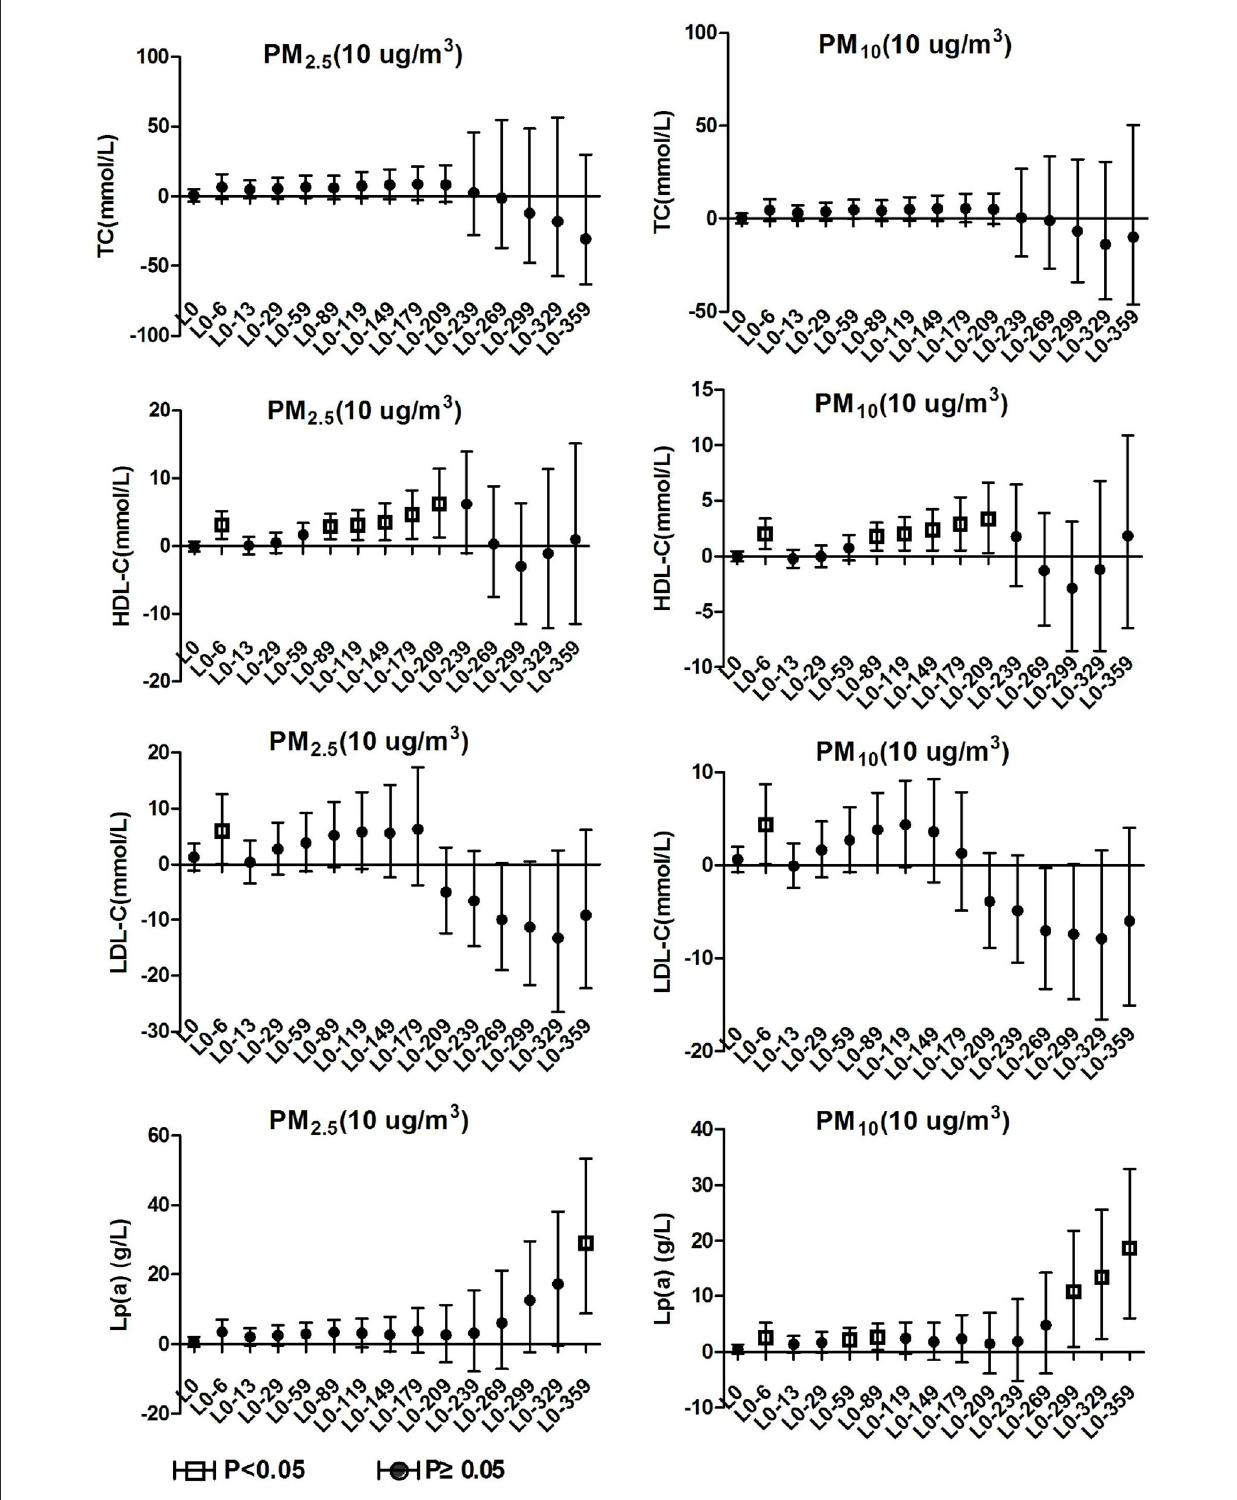
FIGURE4 Effect of PM 2.5 and PM 10 on blood lipid in hypertension inpatients without arteriosclerosis.